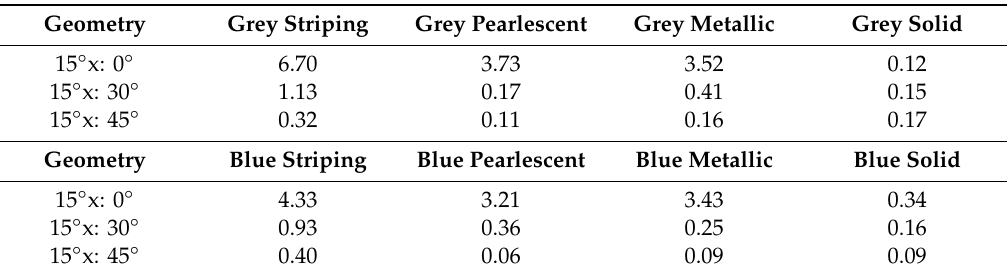
Table 2. Mottling-striping indices M St for the gray and blue samples with stripes; and the pearlescent, metallic and solid samples without striping at the geometries of 15 ◦ x:0 ◦ , 15 ◦ x:30 ◦ and 15 ◦ x:45 ◦ , and under white LED illumination.